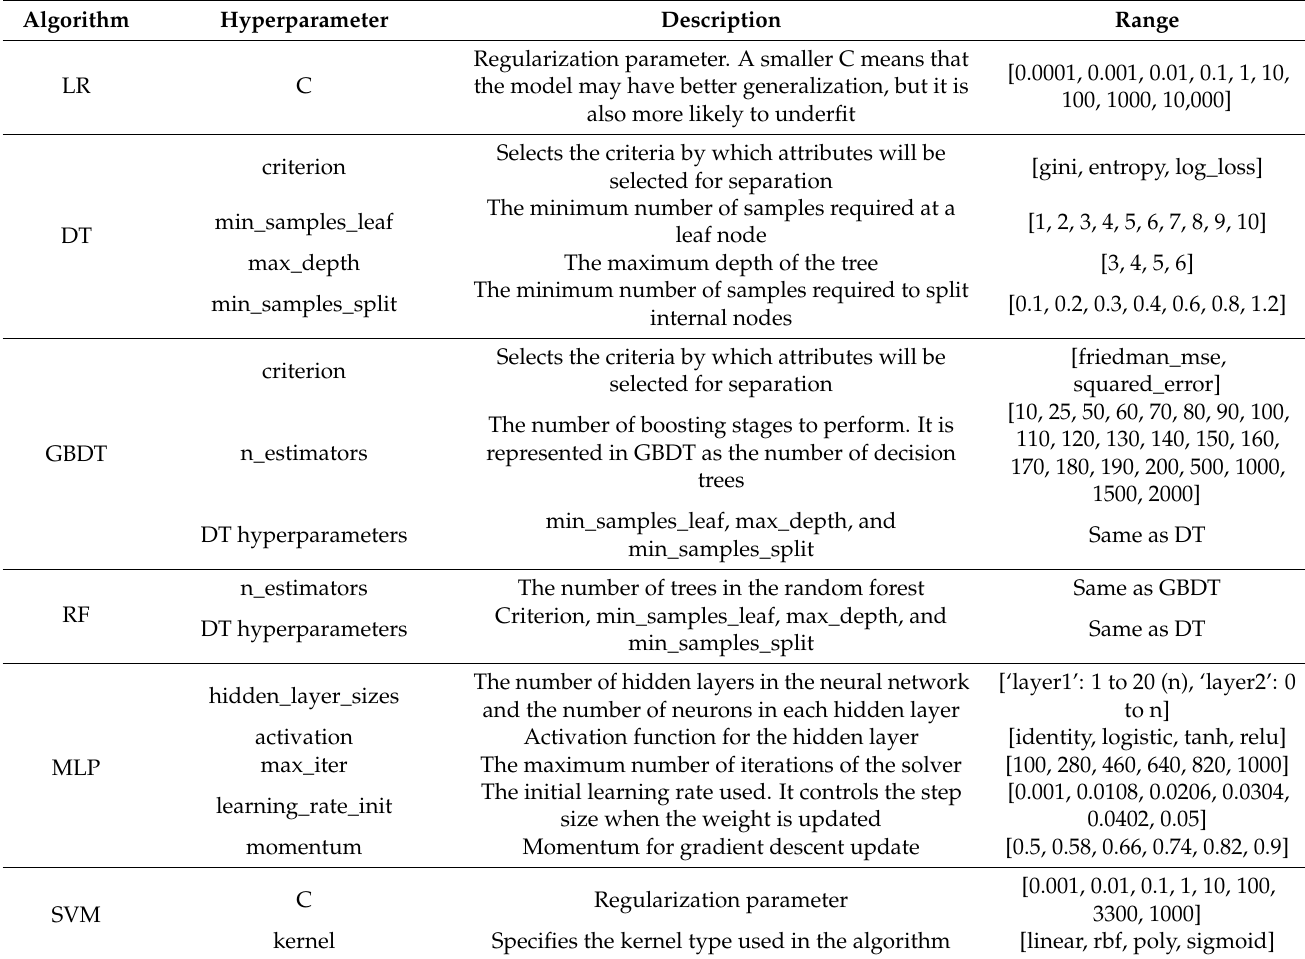
Table 2. Hyperparameter settings